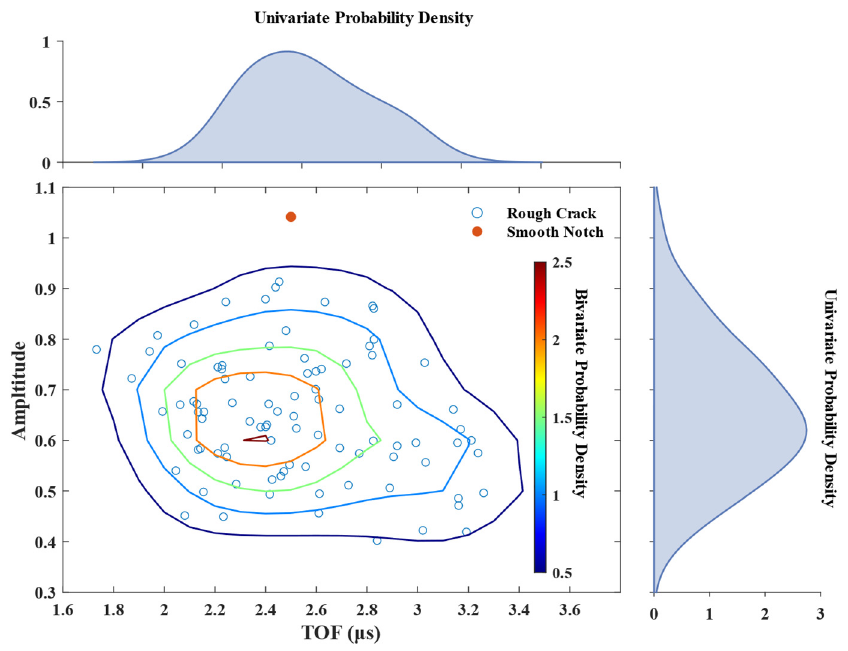
Figure 10. Scatter plot of the amplitude and